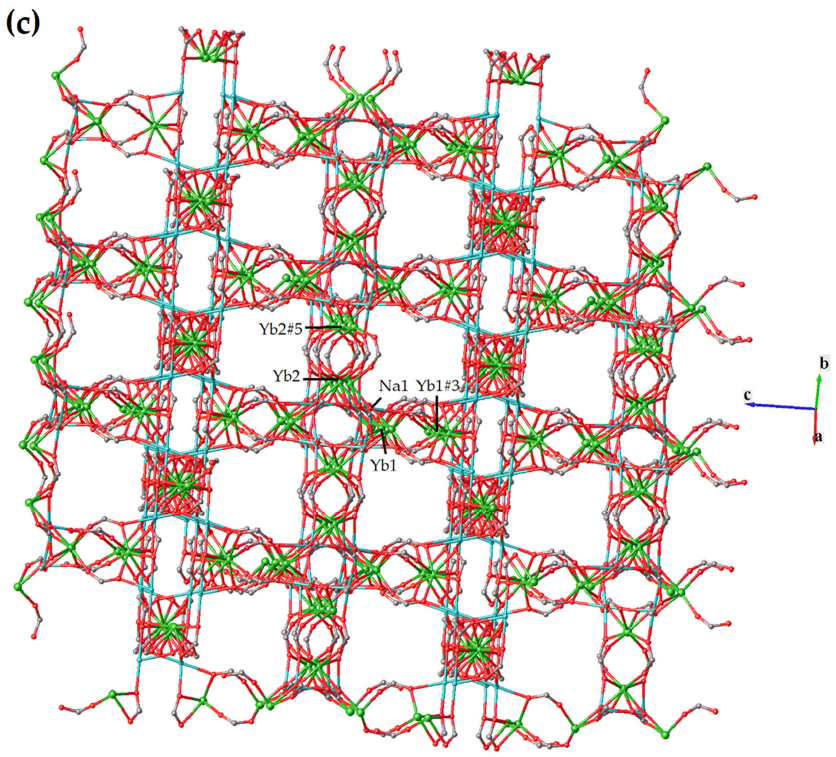
Figure 5. ( a ) Asymmetric unit of [NaYb(3fur) 4 ] n ( 2Yb ) (representative of 2RE = 2Ho, 2Y, 2Er, 2Lu) ( b ) The immediate coordination environment around Yb1, Yb2 and Na1 metals atoms in 2Yb (furan rings are omitted for clarity); Selected bond lengths (Å) and angles (°) (Data for all 2RE in Supplementary information; Tables S5 and S6). 2Yb Yb1 ‐ O1 2.360(3), Yb1 ‐ O2 2.432(3), Yb1 ‐ O4 2.208(3), Yb1 ‐ O5#2 2.321(3), Yb2 ‐ O7 2.317(3), Yb2 ‐ O8 2.495(3), Yb2 ‐ O10 2.180(3), Yb2 ‐ O11#6 2.349(3), Na1 ‐ O1 2.317(3), Na1 ‐ O2#1 2.338(4), Na1 ‐ O5#2 2.428(4), Na1 ‐ O7 2.323(4), Na1 ‐ O8#4 2.369(4), Na1 ‐ O11#6